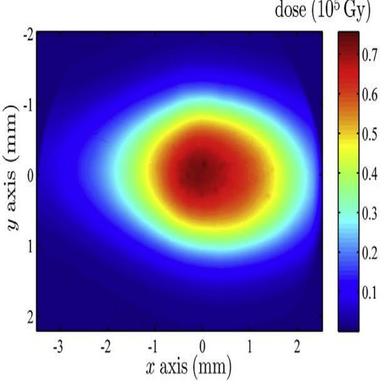
Dose-map obtained from the image of by using the procedure described in the text.